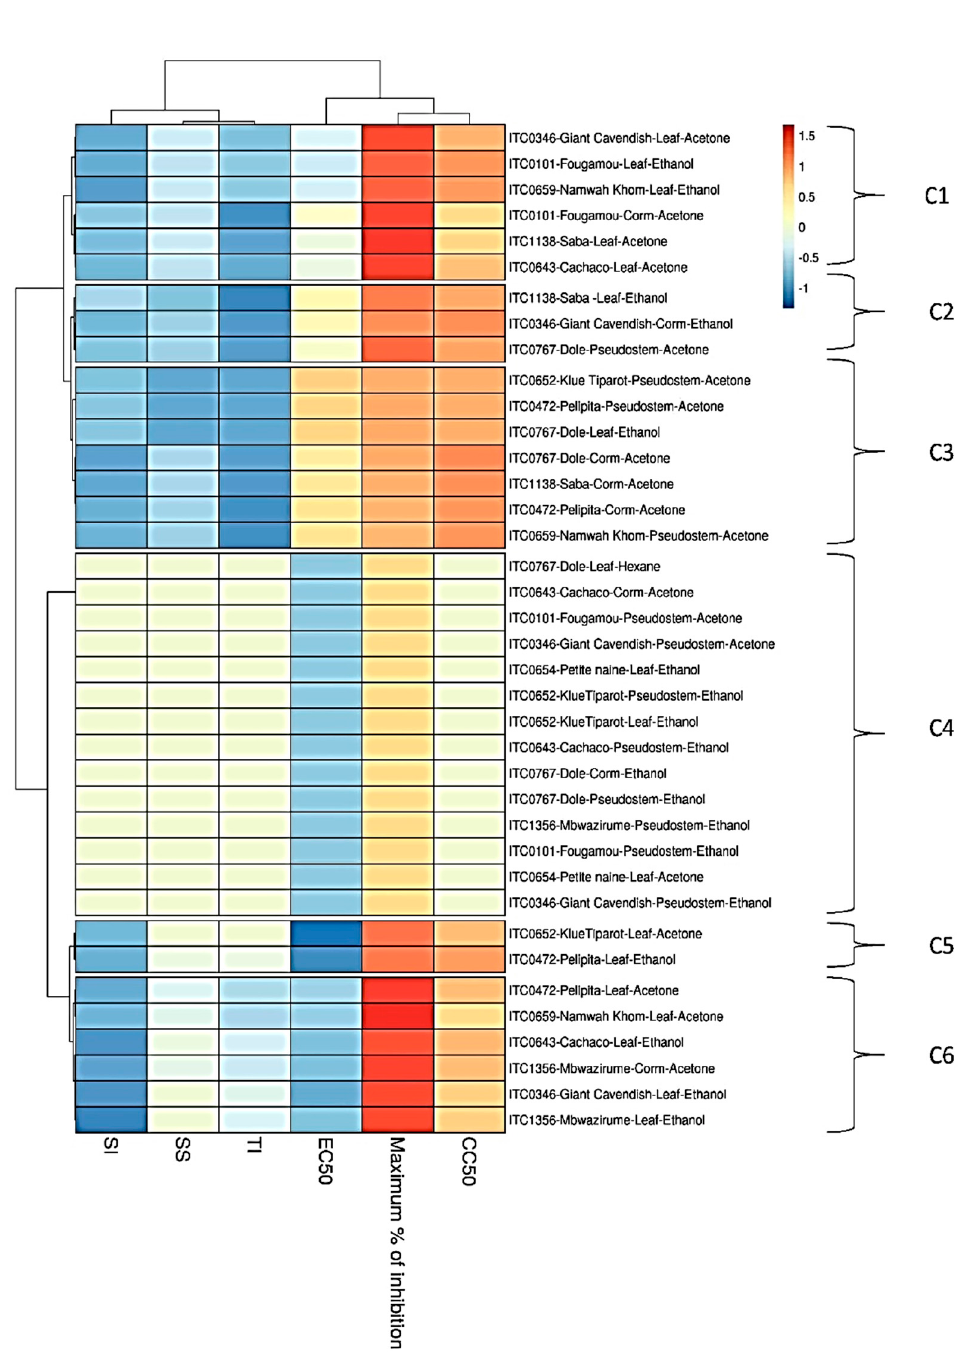
Figure 3. Heat map and clustering of anti-CHIKV activity of extracts from banana cultivars’ plant part. EC 50 = 50% Effective Concentration (concentration at which 50% inhibition of virus replication is observed). CC 50 = 50% Cytostatic/Cytotoxic Concentration (concentration at which 50% adverse effect is observed on Vero cells in parallel with antiviral assay). SI = Selectivity Index (CC 50 /EC 50 ). SS = Selectivity Surface (integrated surface delineated by the EC 50 curve, the CC 50 curve and the 50% horizontal). TI = Therapeutic Index (SS × 10logSI). C1–C6: different clusters.